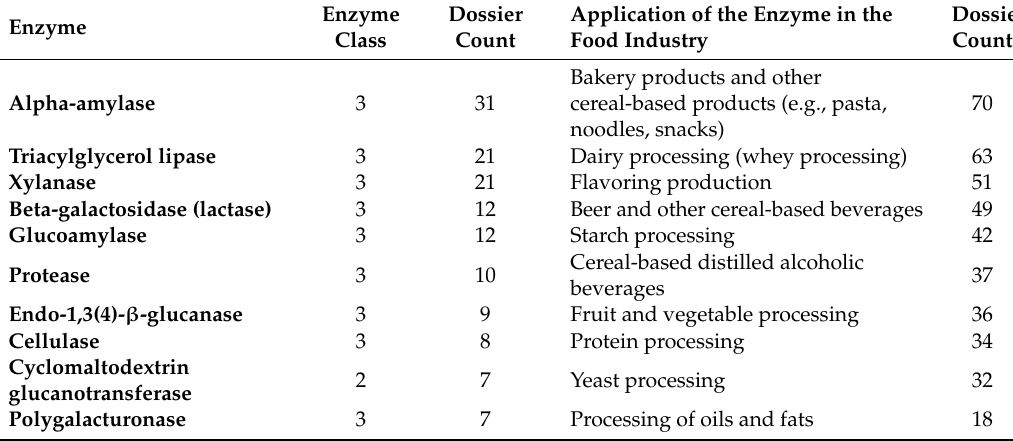
Table 2. Overview of the top ten food enzymes (FE) mentioned in the 303 submitted dossiers for safety. For each enzyme, the number of submitted dossiers is represented and the enzyme class number is given. The ten most mentioned food application uses are also shown, along with the corresponding number of